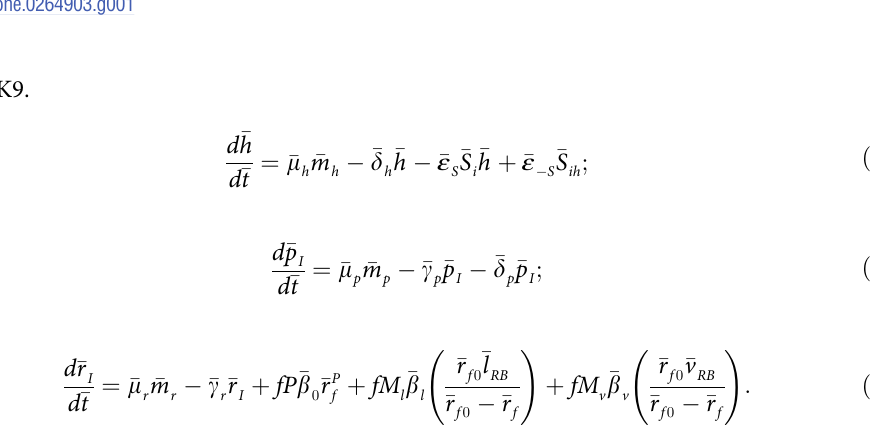
Fig 1. The model of cholesterol-lipoprotein metabolism and interaction with lipid-lowering agents in a hepatocyte. Inside the cell (nucleus and cytoplasm), transcription of HMGCR (H), LDLR (R) and PCSK9 (P) mRNA (at rates μ mh , μ mr , and μ mp , respectively) is activated by SREBP- 2 ( κ , κ , κ ), and the synthesis occurs at rates μ , μ , and μ , respectively. Cholesterol (C) is produced by the activity of HMGCR ( μ mh mr mp h r p negatively regulates SREBP-2 ( κ ). LDLR ( γ ) and PCSK9 ( γ ) are transported to the cell membrane and extracellular space, respectively. In the c r p extracellular space, VLDL, LDL and PCSK9 bind/unbind to LDLR on the cell surface ( α V , α l , α P ). LDLRs, both bound and unbound to lipoproteins or PCSK9 are endocytosed, and part of LDLRs is recycled in the intracellular space. Cholesterol is extracted from internalised lipoproteins ( γ V and γ l ). In the extracellular space, interaction of PCSK9 with anti-PCSK9 agents (A, � ε into the cell (clearance CL S ) and inhibit HMGCR ( ε S ). The degradation pathways are not shown for better visualization. The scheme is created on the basis of the scheme presented in [18]. The newly introduced pathways are highlighted.